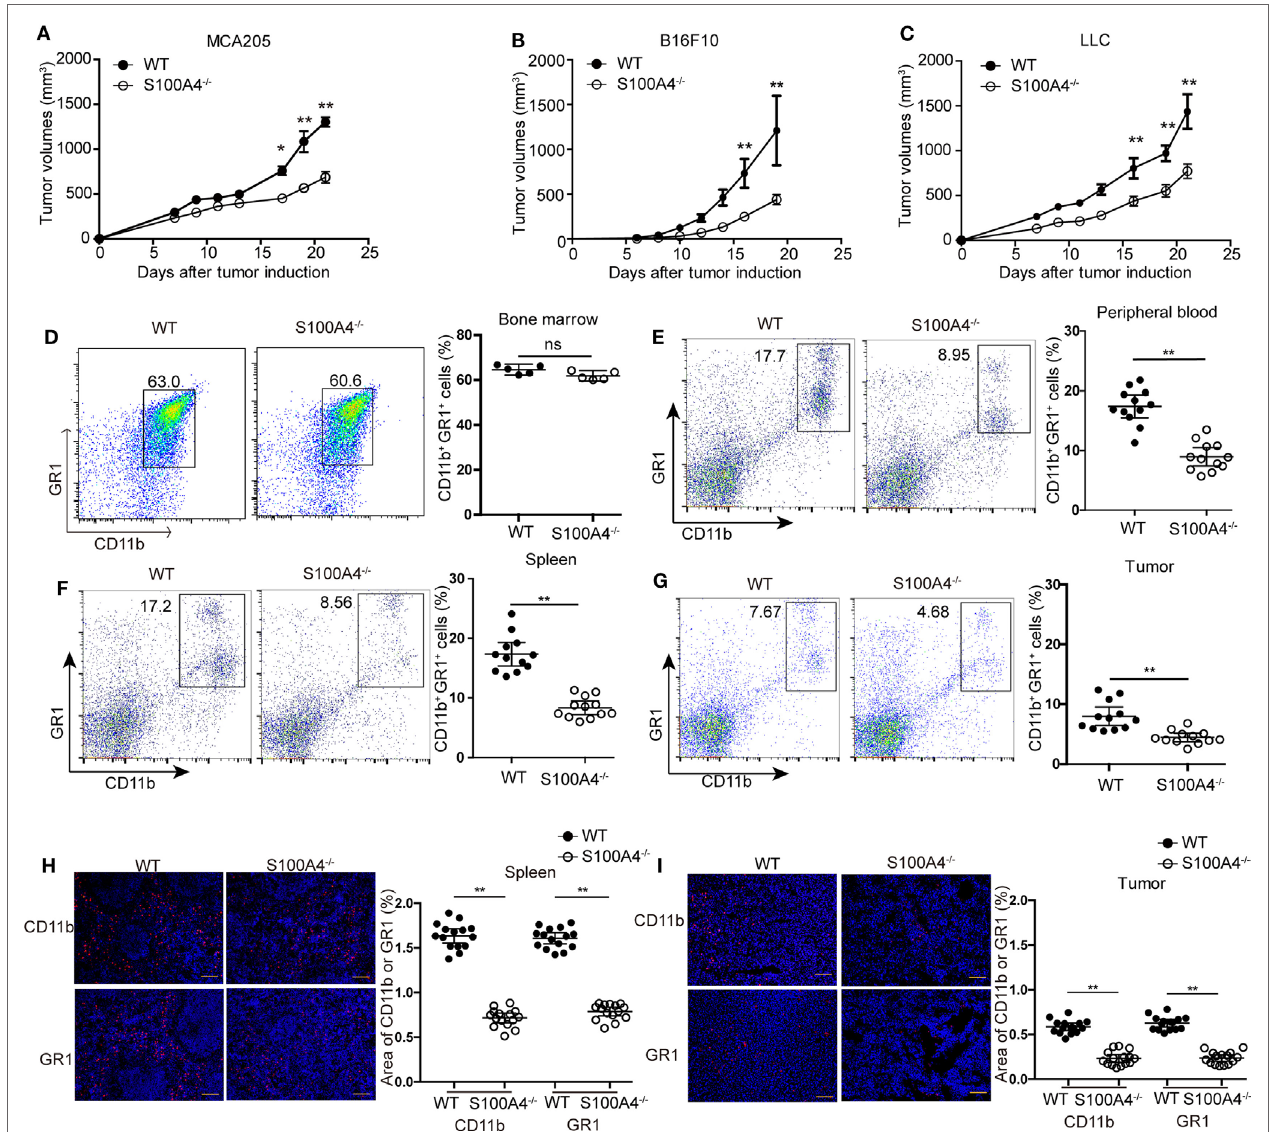
FigUre 1 | Tumor growth and accumulation of myeloid-derived suppressor cells (MDSCs) in S100A4 − / − mice. Wild type (WT) and S100A4 − / − mice were subcutaneously injected with 5 × 10 5 (a) MCA205, (B) B16F10, or (c) Lewis lung cancer (LLC) tumor cells. Tumor volumes were monitored over time after tumor-cell inoculation. Results represent three independent experiments; mean ± SEM, n = 5 mice per group. * P < 0.05, ** P < 0.01, and Mann–Whitney. (D–i) WT and S100A4 − / − mice were subcutaneously injected with 5 × 10 5 MCA205 cells. Seventeen days after tumor-cell inoculation cells isolated from (D) bone marrow, (e) peripheral blood, (F) spleen, or (g) tumors were stained for CD11b and GR1 and assessed by flow cytometry. Percentages of CD11b + GR1 + MDSCs relative to total cells are given. Shown is combined raw data from three independent experiments. Mean and 95% CI, n = 5–12 mice per group; ** P < 0.01, Mann–Whitney. (h,i) CD11b + and GR1 + cells in (h) spleen or (i) tumor sections of WT and S100A4 − / − mice 17 days after tumor-cell inoculation were visualized by immunofluorescence staining (red). Nuclei were counterstained with DAPI. Original magnification, × 100. Scale bars: 100 µm. The area of CD11b or GR1 staining was analyzed by ImageJ software. Combined raw data from three independent experiments are shown. Mean and 95% CI, 15 sections from n = 5 mice per group. ** P < 0.01,